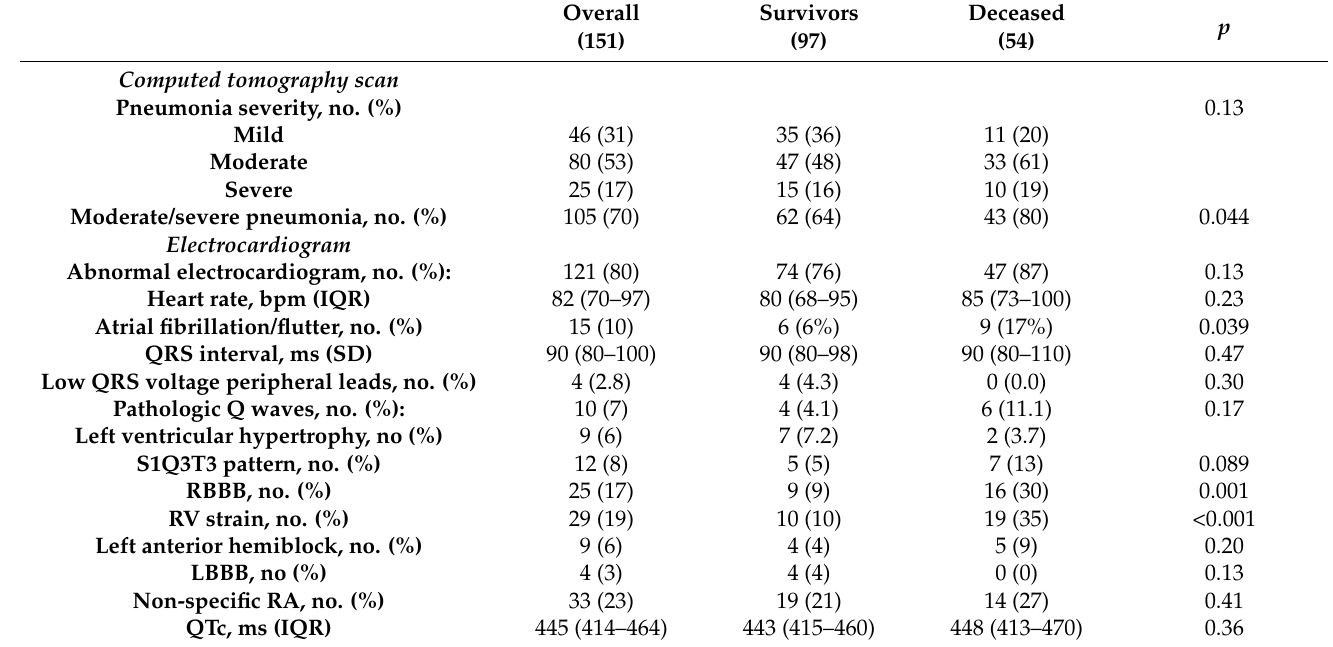
Table 2. Computed tomography scan and electrocardiographic